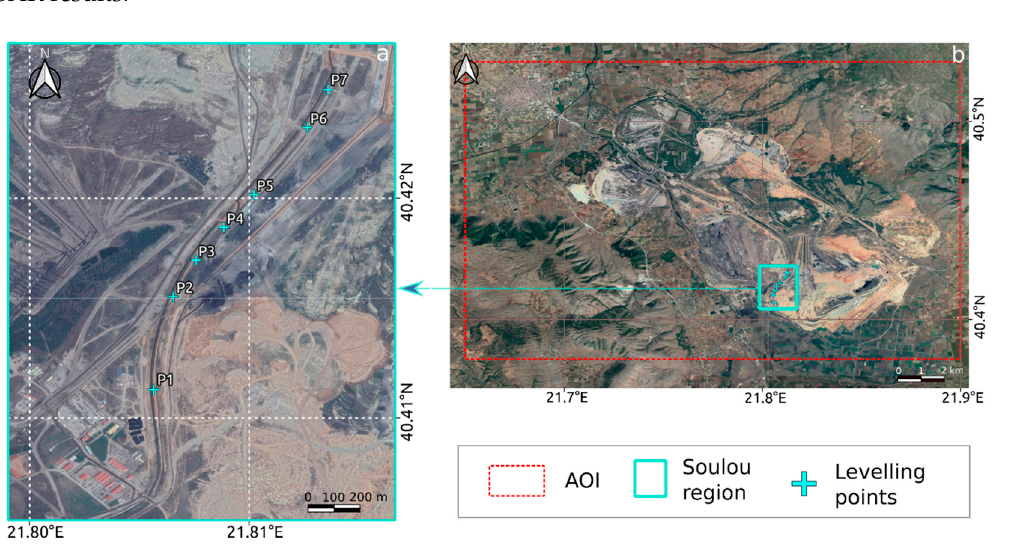
Figure 2. In-situ deformation measurements. ( a ) location of leveling points in Soulou region (light blue rectangle); ( b ) the spatial extent of the AOI. Reference system is WGS84. © Google Earth background map Copyright 2018. Map was created using QGIS. QGIS Development Team, 2019. QGIS Geographic Information System (Version 3.8.1). Open Source Geospatial Foundation Project. http://qgis.osgeo.org.